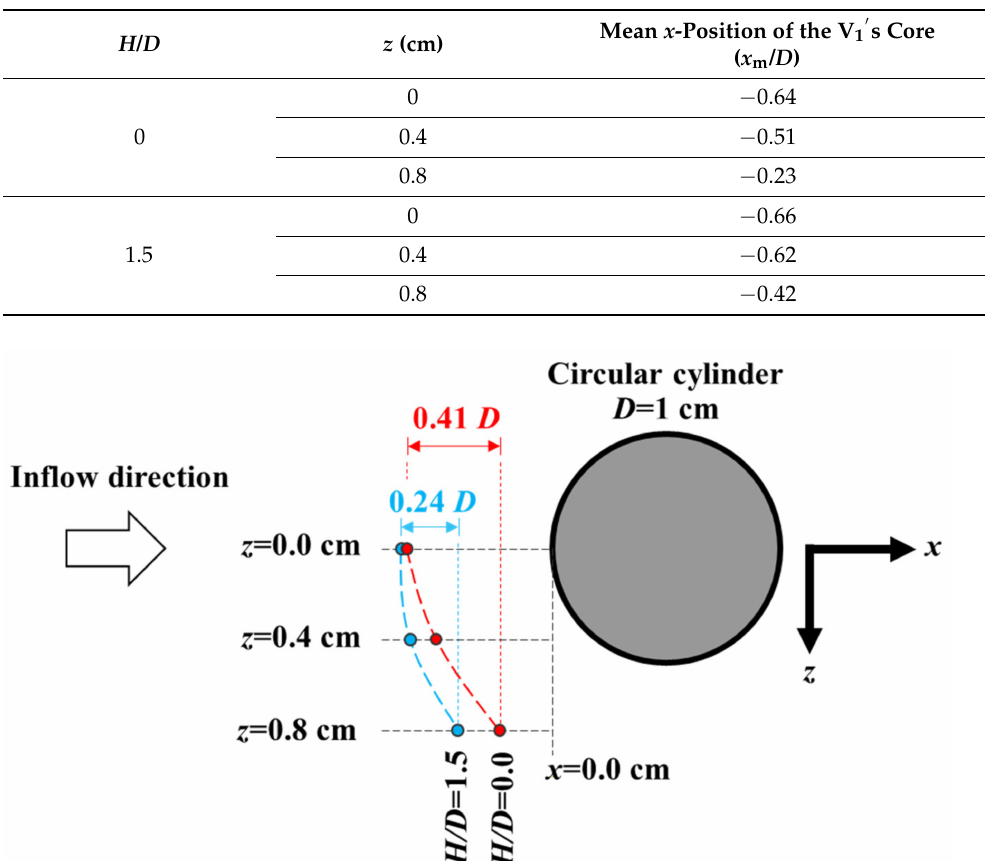
Figure 17. Comparison between spanwise extensions (breadths) of the HSV for H / D = 0 (in red) and 1.5 (in